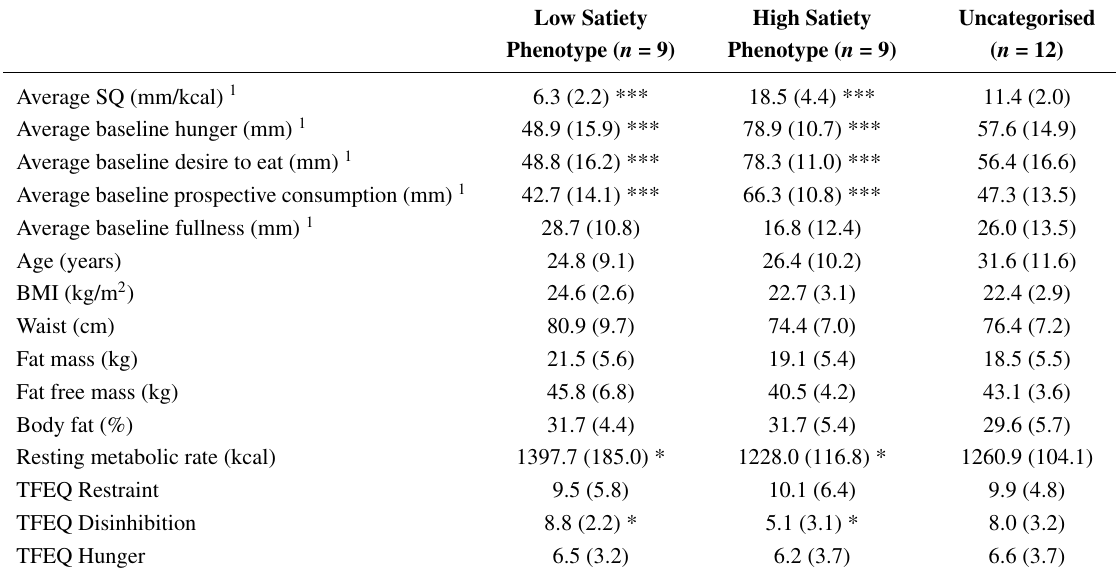
Mean (standard deviation) age, appetite sensations, anthropometrics, body composition and psychometric trait characteristics for the low and high satiety